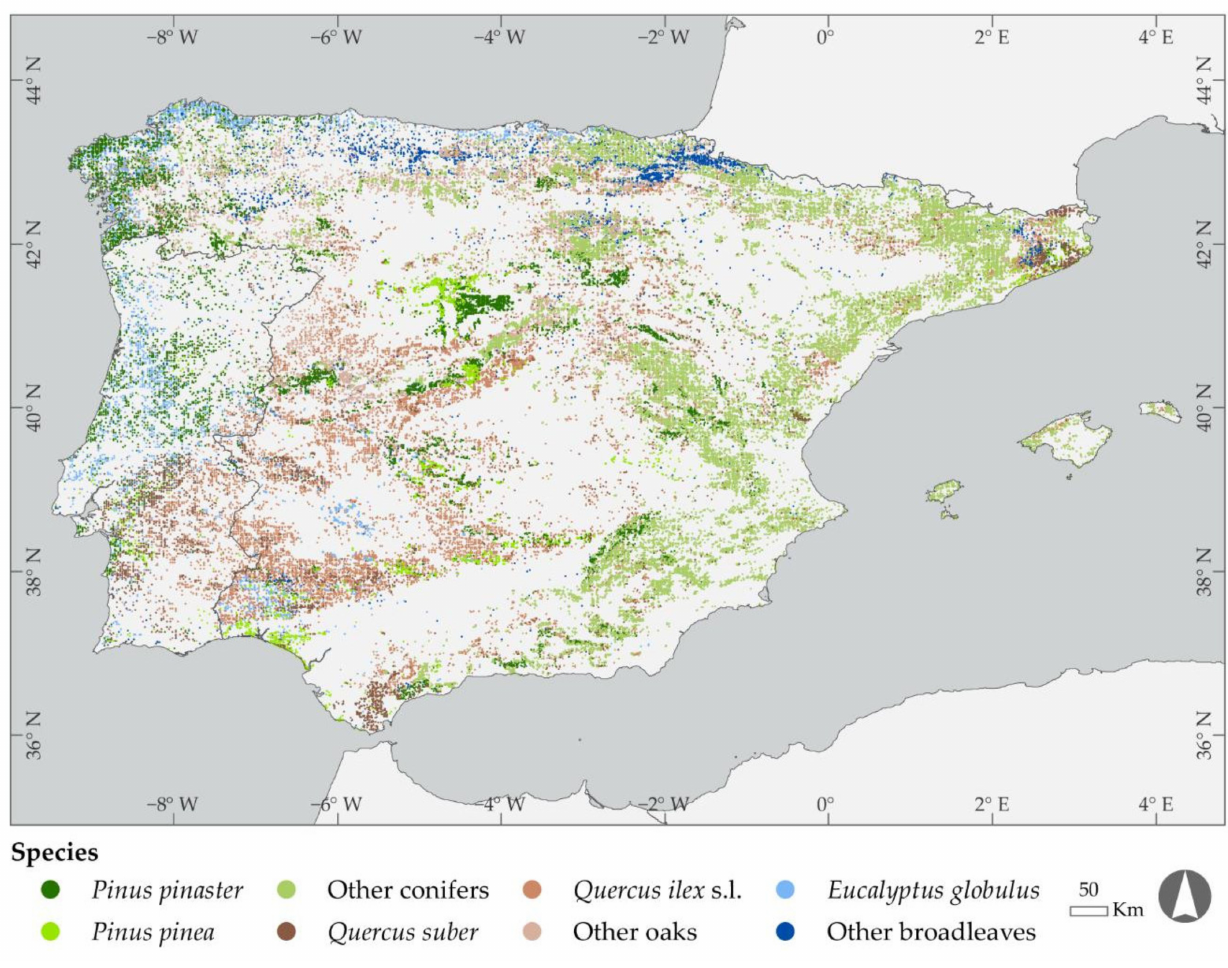
Figure 13. Geographical distribution of the tree species/groups in the Iberian Peninsula according to NFIs data. The estimated CBD values per plot are plotted for the Iberian Peninsula in Figure 14a. Higher values of CBD are mostly located in the north and Atlantic coast of the Iberian Peninsula, which is an area with dominance of pines and eucalypts (Figure 13). The estimated CLBD values per plot are shown in Figure 14b. Larger CLBD values are also in areas dominated by Pinus pinaster and Eucalyptus globulus in central and northern Portugal and Pinus pinea in central Spain. In southern Spain areas with high CBD with Quercus ilex s.l. (Figure 13) have lower CLBD values because of the small tree densities in the typical agroforestry “dehesa” type